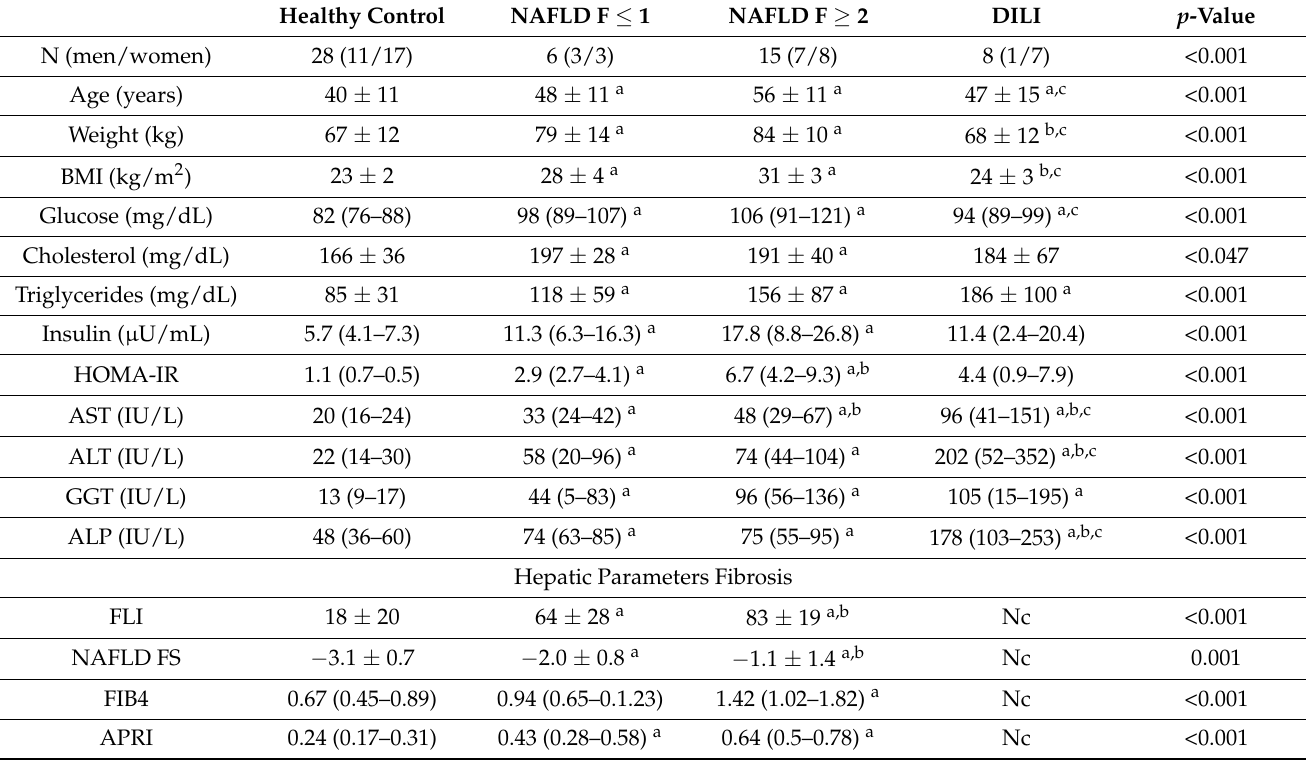
Table 1. Anthropometric and biochemical variables across the different study groups. Healthy